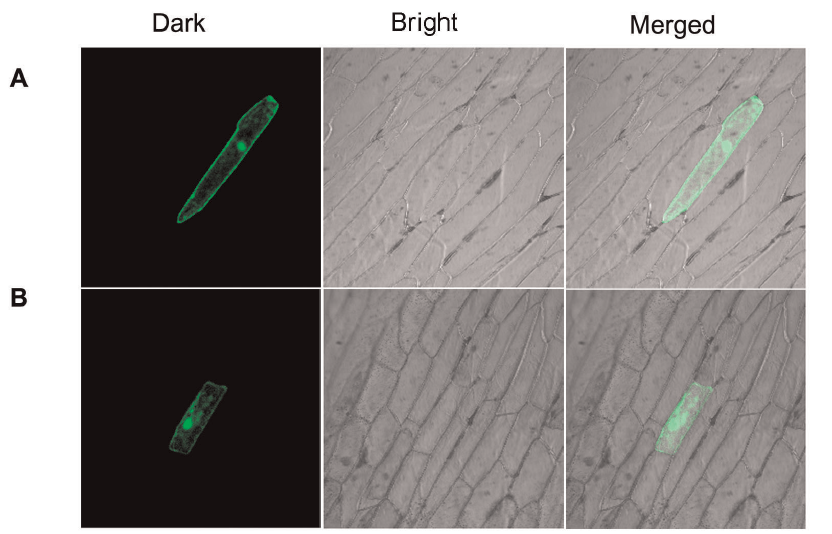
Figure 5. Subcellular localization of TaRab7 protein. Onion epidermal cells were transformed with plasmids expressing the fusion protein and green fluorescent protein (GFP) by bombardment. All images were observed with a confocal microscope. (A). Onion epidermal cells expressing the GFP alone driven by the 35 S promoter. (B). Onion epidermal cells expression the TaRab7-GFP fusion protein.